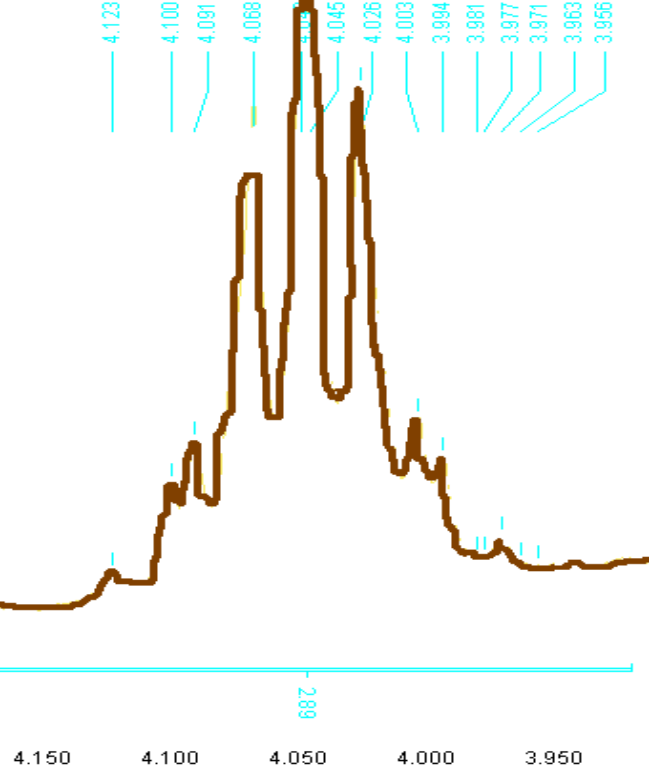
-CH of compound 8g . 2 3